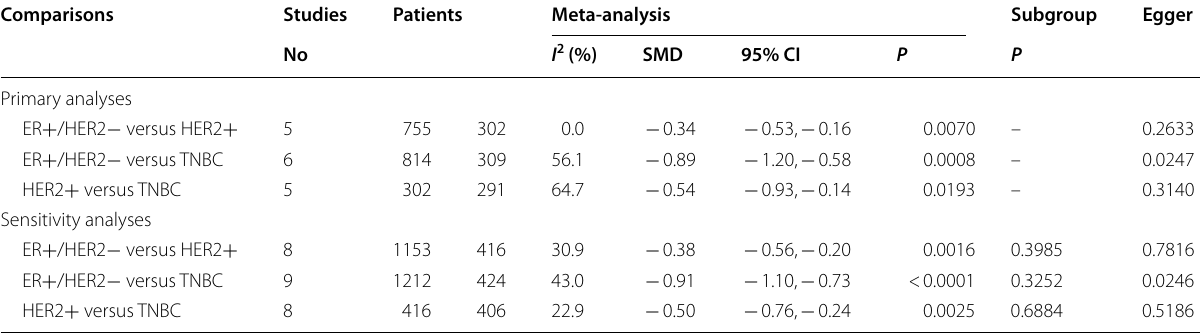
Data derived from the primary and sensitivity analyses are presented CI, confidence interval; ER, estrogen receptor; HER2, human epidermal growth factor receptor 2; SMD, standardized mean difference; TNBC, triple negative breast cancer